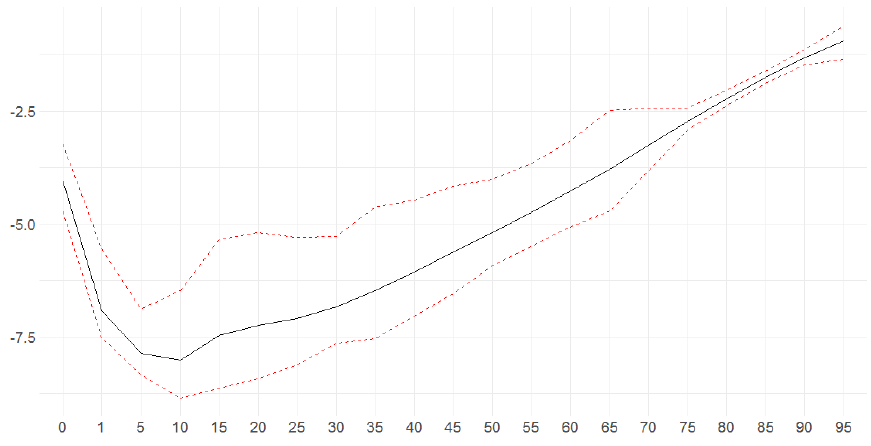
Figure 40. The Bayesian posterior mean estimates with 95% posterior credible intervals average over time for α + ˜ F t (cid:36) t for DFM-PC-D-r.